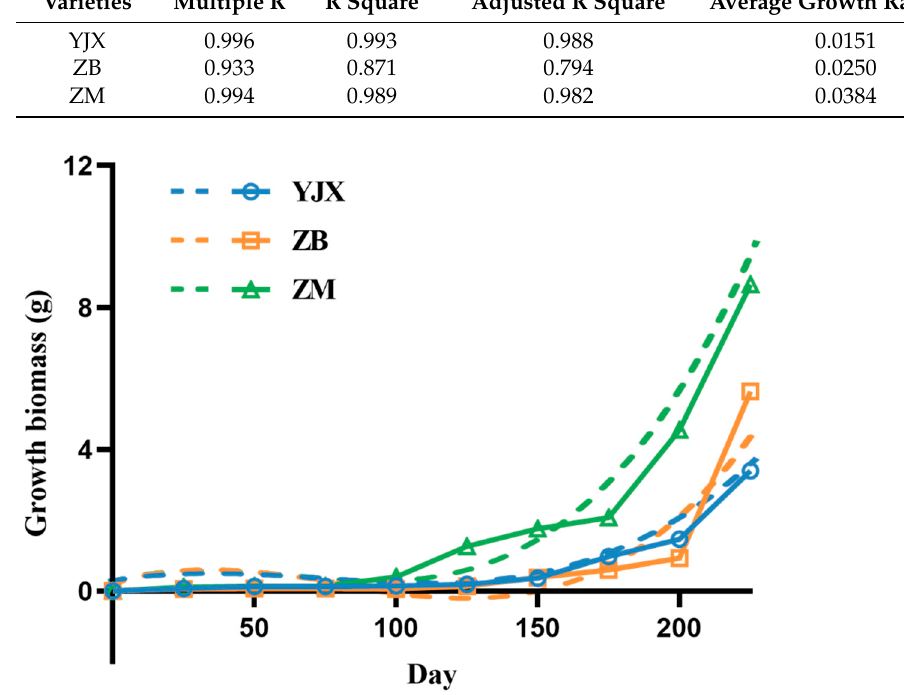
Figure 3. Growth curve of cutting seedings. The solid line is the true value of the growth biomass, and the dashed line is the predicted value of growth biomass after regression. Varieties of cutting seedlings: Yujinxiang (YJX), Zhongbai 1 (ZB), and Zhongming 6 (ZM).